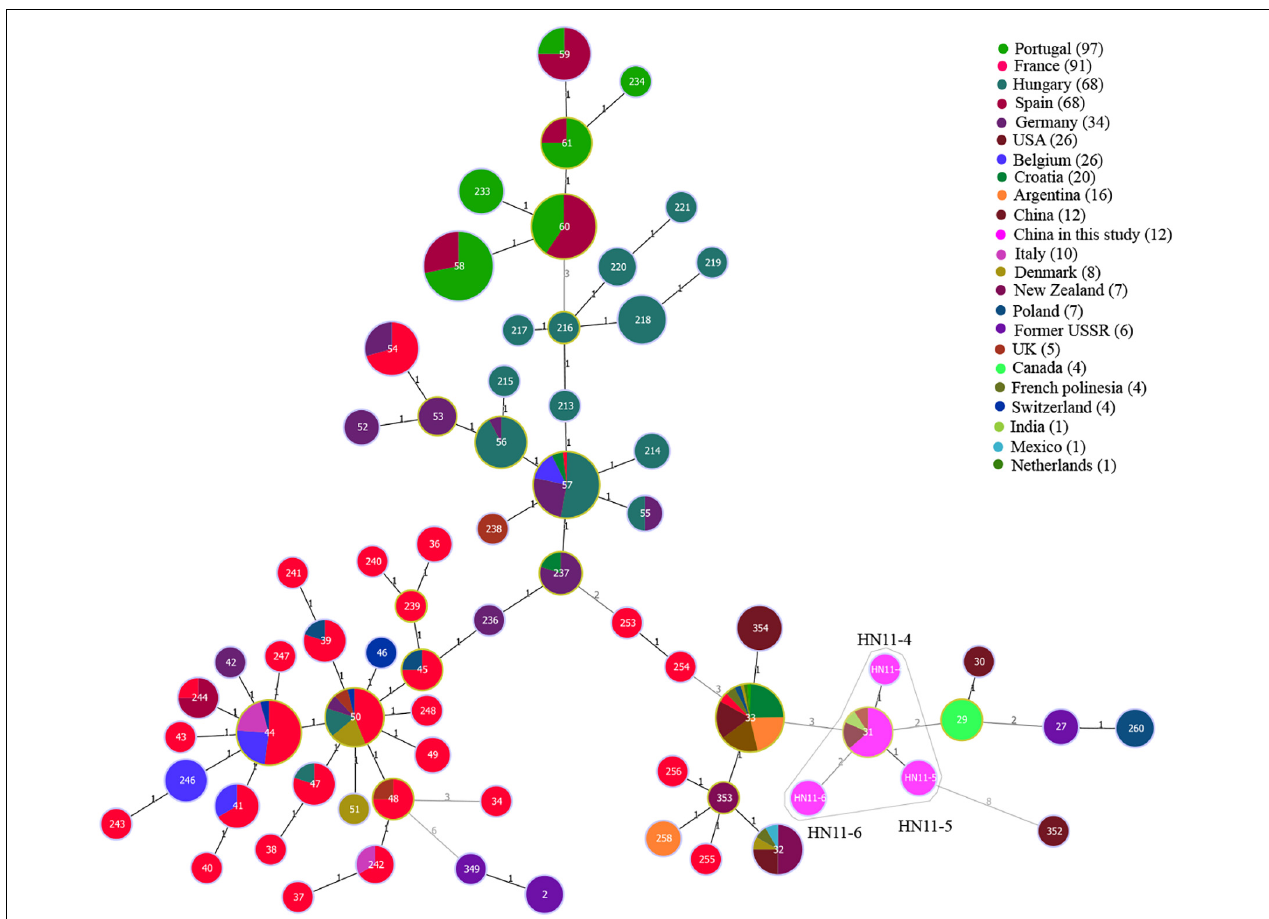
FIGURE 4 | A MST for B. suis using the MLVA-11 data with the Portugal isolates (light green), France isolates (red), Hungary isolates (dark green), Spain isolates (Danish red), Germany isolates (dark purple), United States isolates (brown red), Belgium isolates (blue), Croatia isolates (emerald-green), Argentina isolates (orange), Italy isolates (dark pink), Denmark isolates (canary yellow), New Zealand isolates (dark Brown), Poland isolates (blue-gray), former USSR isolates (light purple), United Kingdom isolates (light red), Canada isolates (green), French Polynesia isolates (soil orange), Switzerland isolates (dark blue), India isolates (Yellow-green), Mexico isolates (lake blue), Netherlands isolates (green onion), China isolates (brown), and China isolates from our study